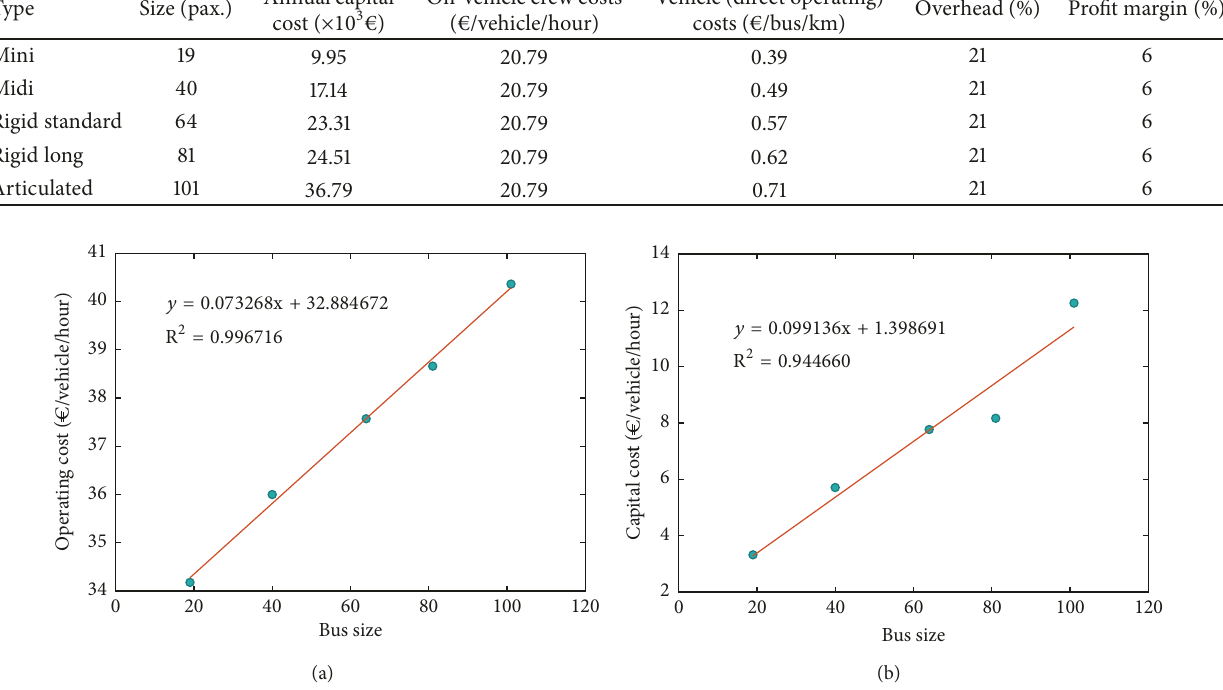
Figure 9: (a) Hourly operating cost per vehicle with respect to bus size; (b) hourly capital cost per vehicle with respect to bus size. Data source: Australian Transport Council